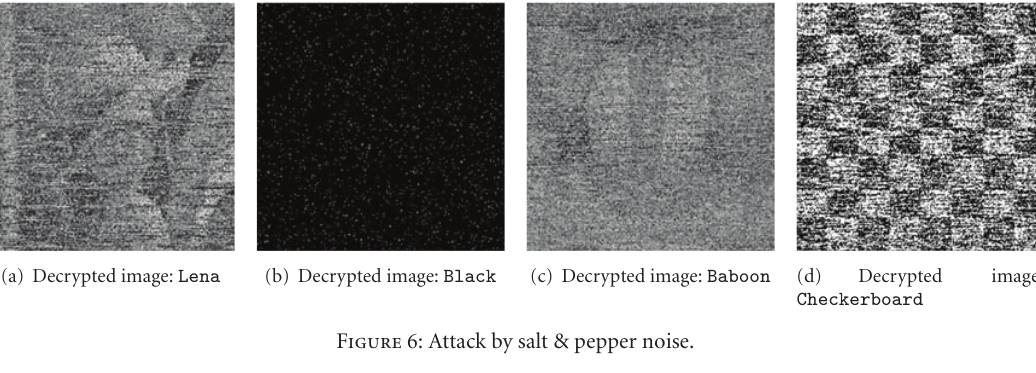
Figure 6: Attack by salt & pepper noise.